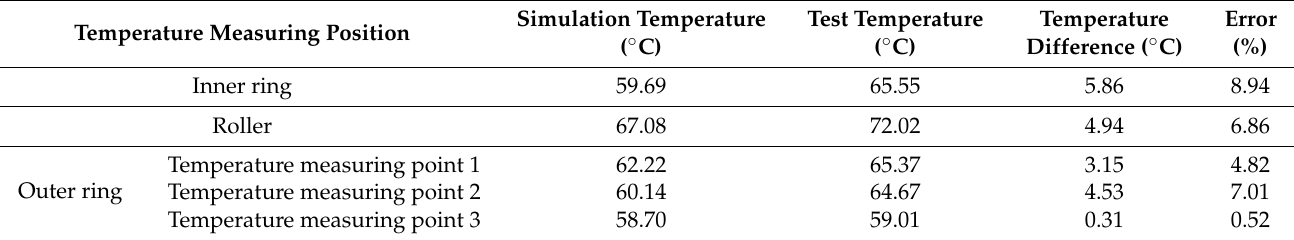
Table 2. Comparison between simulation results and experimental data.